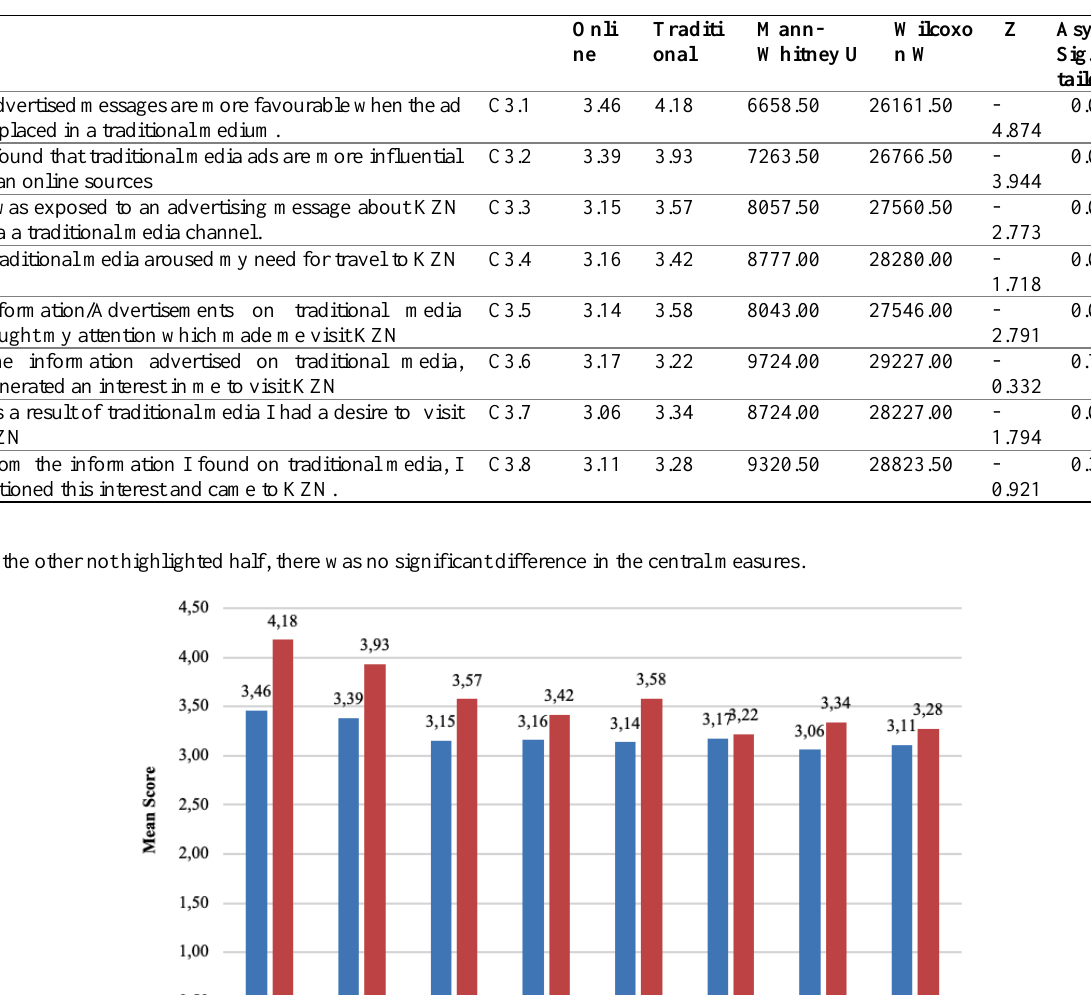
Table 9: Effectiveness of Traditional Media